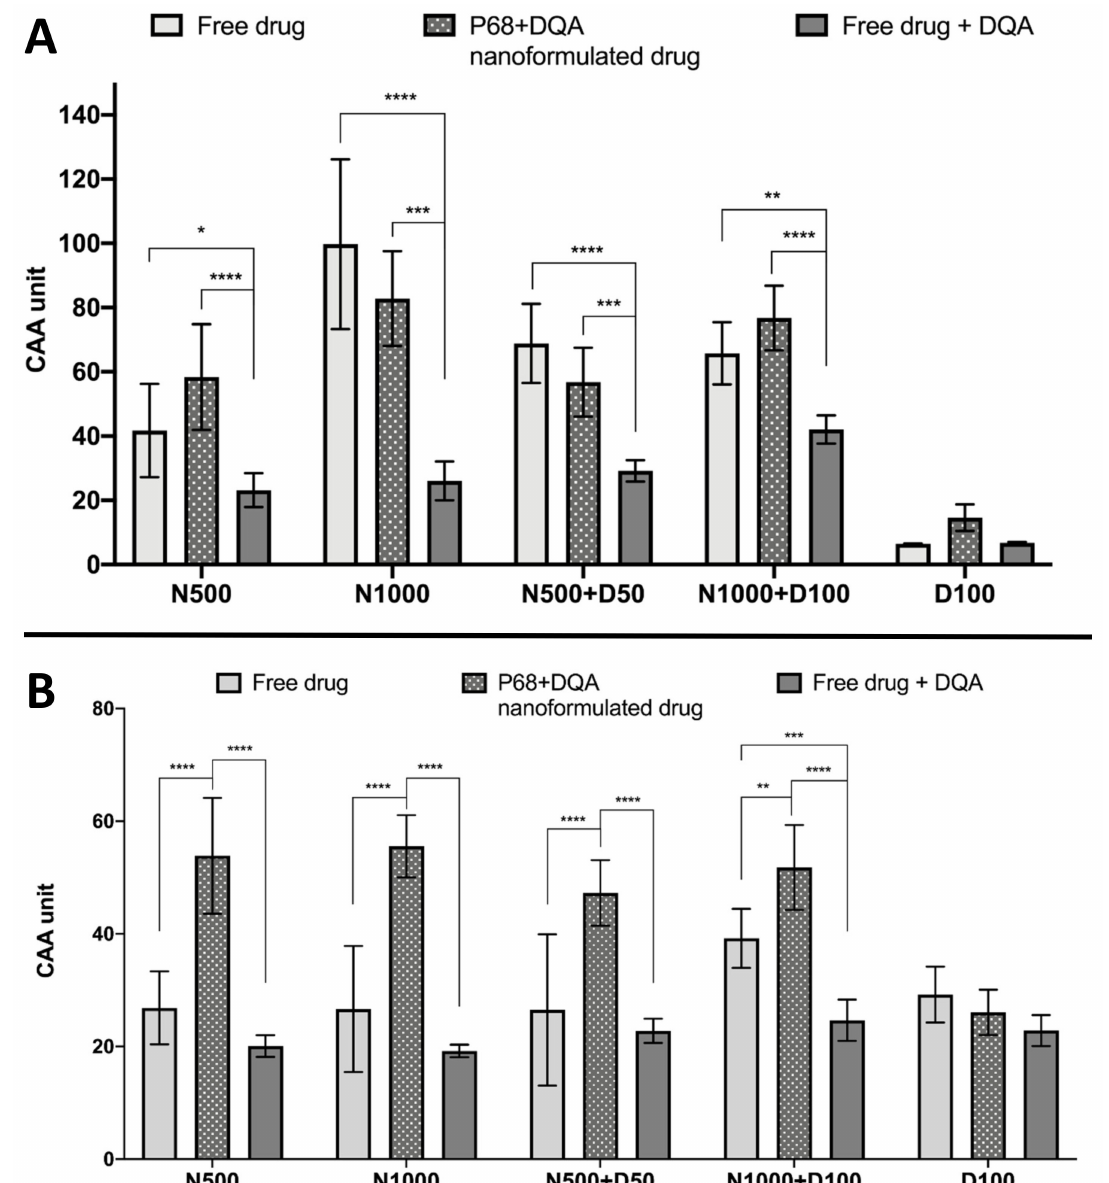
Figure 5. ( A ). Cellular antioxidant activity (CAA) assay results for free-drug, P68 + DQA nanformulated drug and free drug + DQA preparations of 50 or 1000 µ M NAC (N500, N1000), combined NAC and 50 or 100 µ M DFO (N500 + D50, N1000 + D100) and 100 µ M DFO alone (D100) when using 100 µ M rotenone as the prooxidant (mean ± S.D., n = 6). ( B ). Corresponding CAA results when using 600 µ M ABAP as the prooxidant. * represent significance when comparing the P68 + DQA nanoformulated drug to the free-drug and free drug + DQA preparations within the same drug condition (**** p < 0.0001, *** p < 0.001, ** p < 0.01, * p <